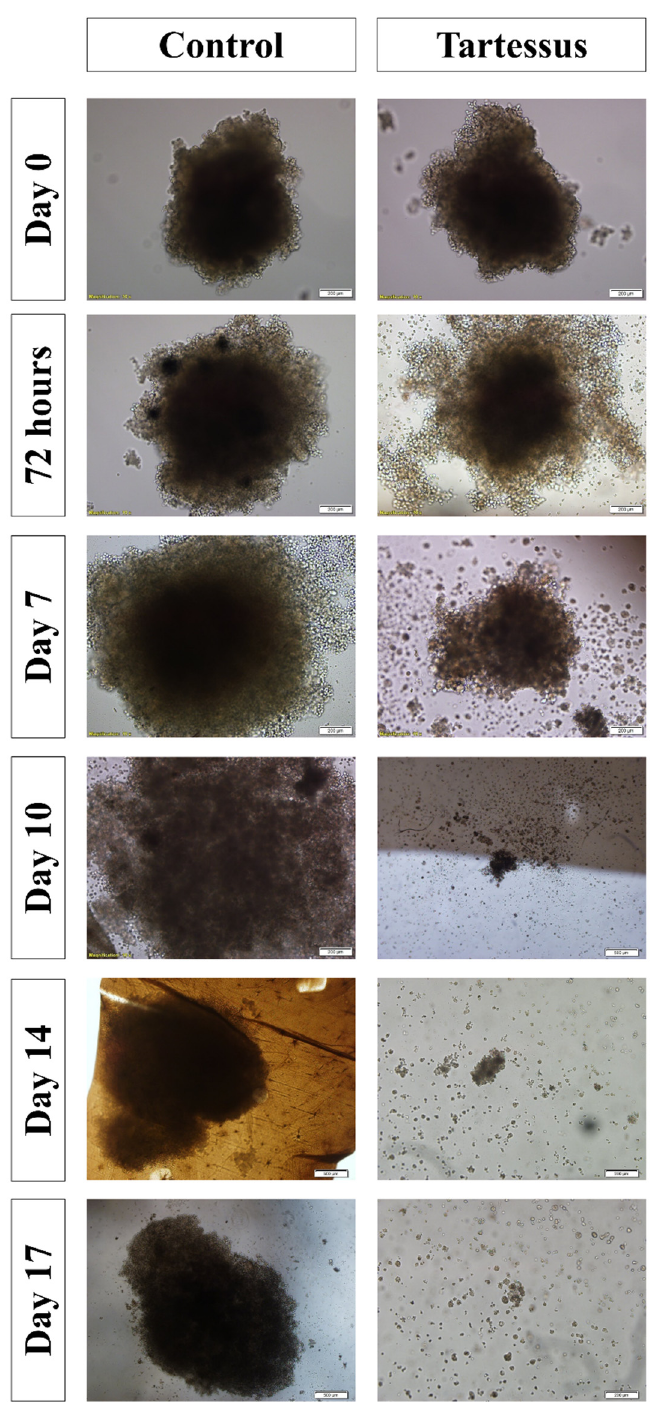
Figure 7. Effect of TARTESSUS without and with encapsulated irinotecan. The area of the spheroids ( µ m 2 , %, fold over control) was measured at 72 h, and on days 7, 10, 14, and 17. Within the control group, the area of the spheroids increased significantly in compar- ison with the starting point of treatment, whose area increased up to 127.86 ± 17.50% over their size at the start of treatment. On day 10, the area increased to a value of 529.21 ± 47.98% ( p < 0.001); on day 14, to a value of 544.79 ± 120.01% ( p < 0.001); and on day 17, the